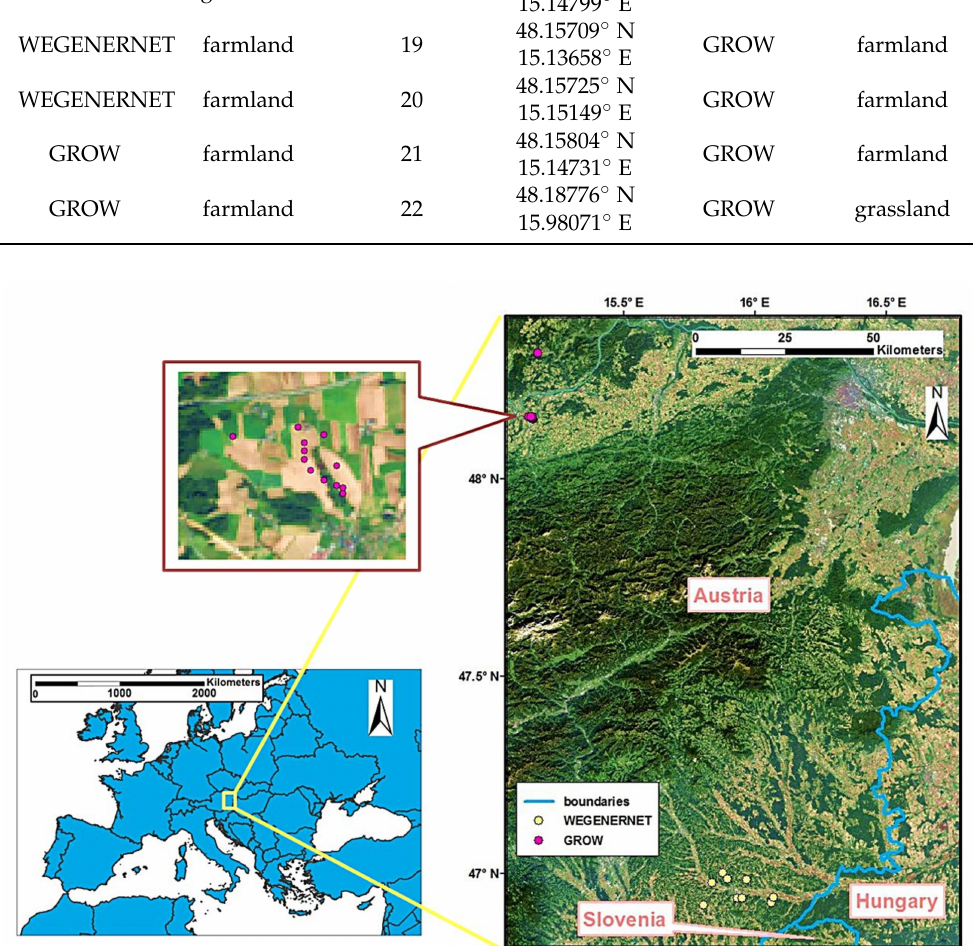
Figure 1. Location of the study area and monitoring